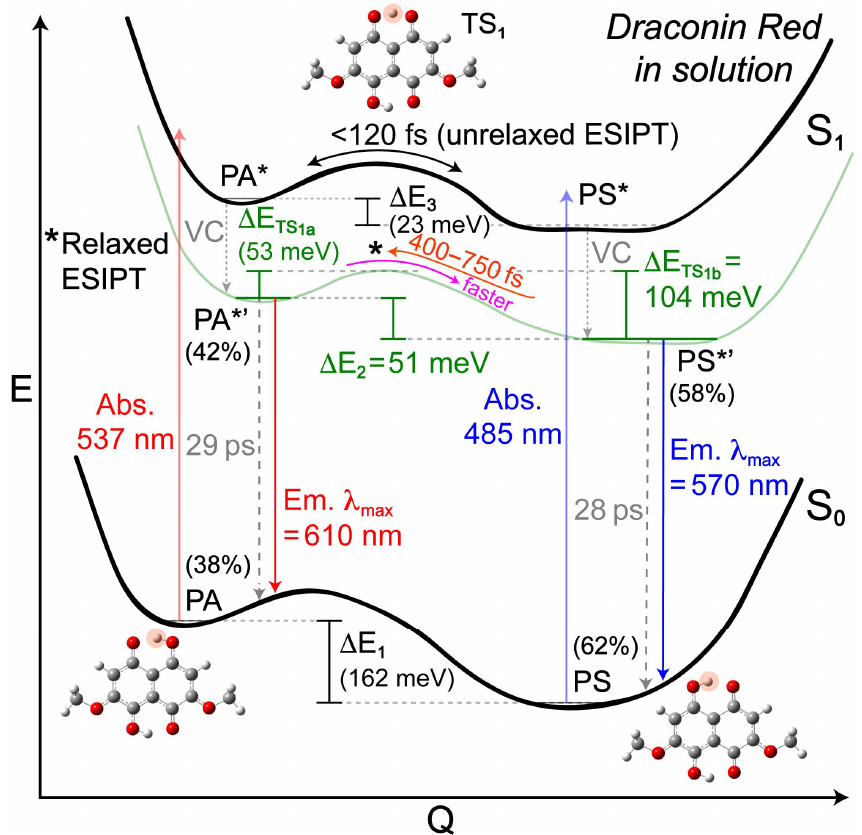
Scheme 1. Ground- and excited-state potential energy surfaces of Draconin Red in solution. See Figure 1a,b for the two interconverting tautomers and Figure 1c for their absorption and emission profiles. The calculated energy differences (in milli-electron volt unit) between various tautomer states are denoted, with TS 1a and TS 1b representing two transition pathways (i.e., the associated ∆ E values are listed in green color for the relaxed excited states of both tautomers). The predicted tautomer population percentages are listed in parentheses by the ground states (PA and PS) and relaxed excited states (PA*’ and PS*’). Solid upward and downward arrows depict electronic absorption (485 nm, violet; 537 nm, orange) and emission (570 nm, blue; 610 nm, red), respectively, while gray dotted and dashed downward arrows show vibrational cooling (VC) and nonradiative relaxation pathways. The unrelaxed and relaxed ESIPT pathways are labeled, with key time constants listed. Adapted with permission from [46]. Copyright 2021 American Chemical